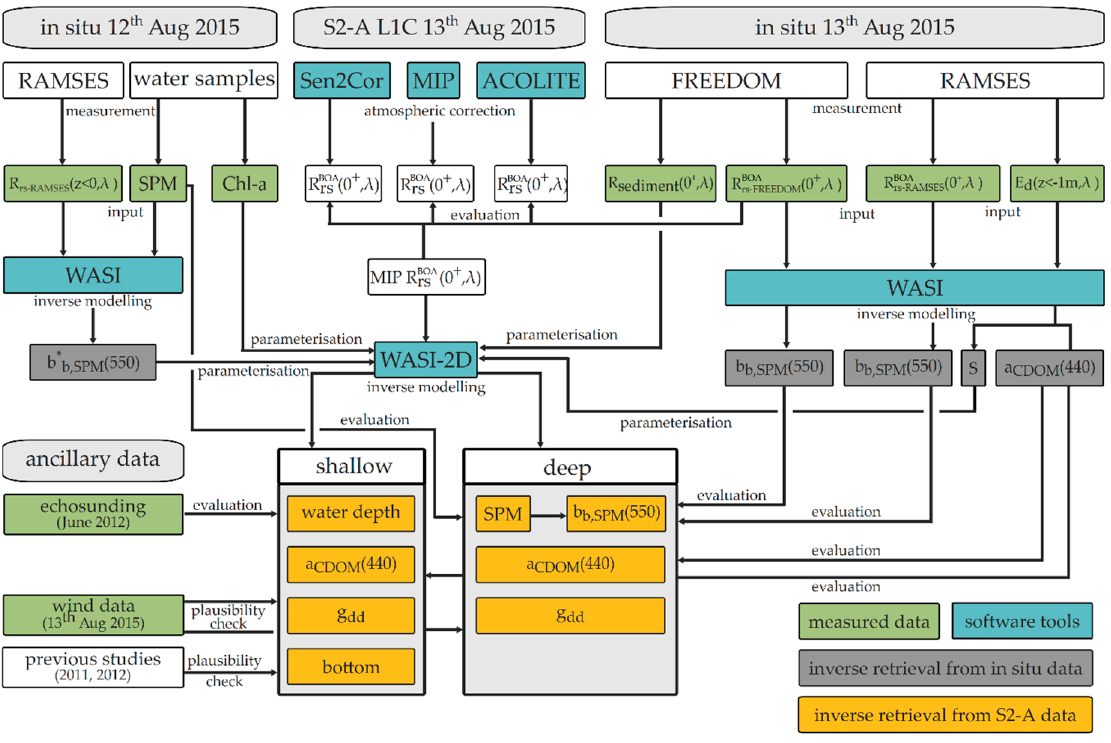
Figure 2. Simplified methodological workflow of the study.